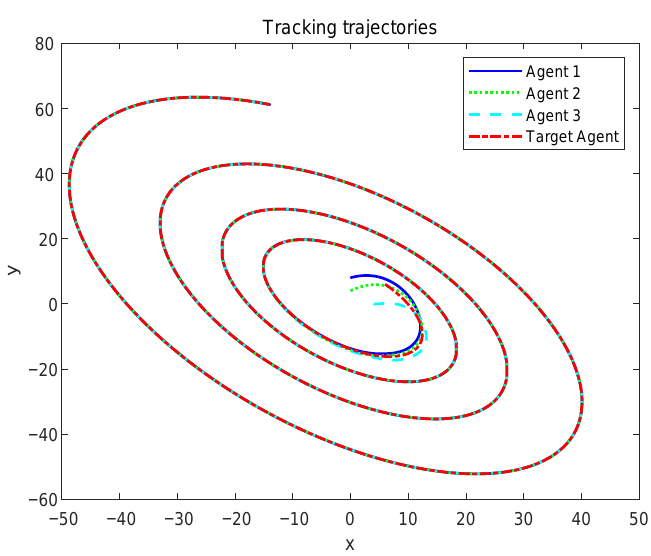
Figure 3. Tracking trajectories of the system.